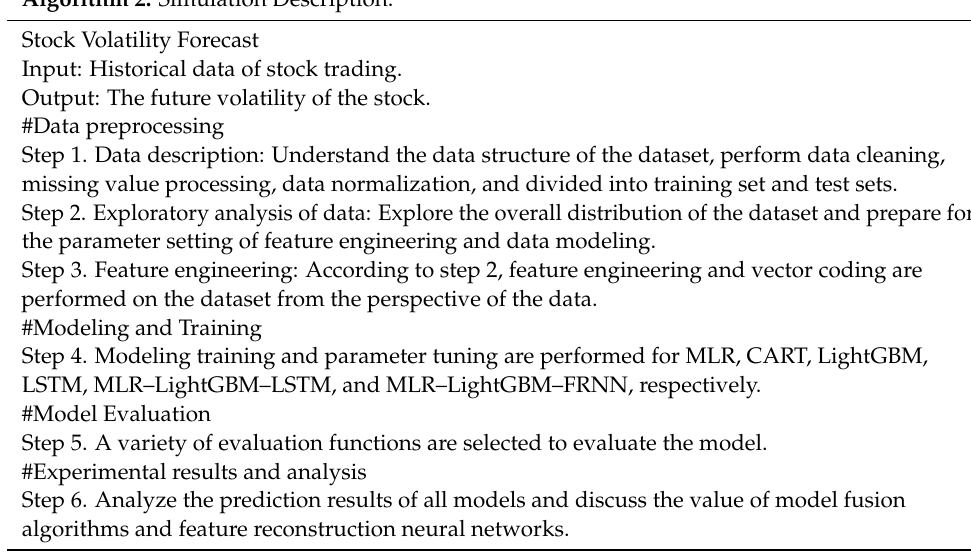
Figure 13. Experimental steps. Algorithm 2. Simulation